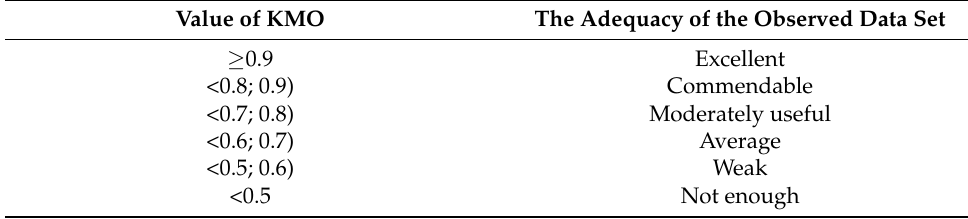
Table 2. The Kaiser and Rice recommendation (1974) (Data from [20]). Value of KMO The Adequacy of the Observed Data Set ≥ 0.9 Excellent Moderately